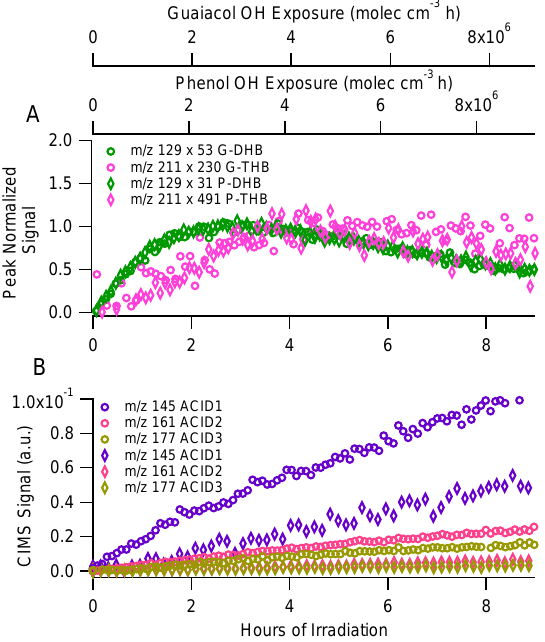
Fig. 6. Common chemical routes in the phenol and guaiacol low- NO x systems. (A) Dihydroxybenzene routes in phenol (diamonds) and guaiacol (open circles). Each CIMS trace is normalized by the peak value. (B) Common acids in phenol (diamonds) and guaiacol (open